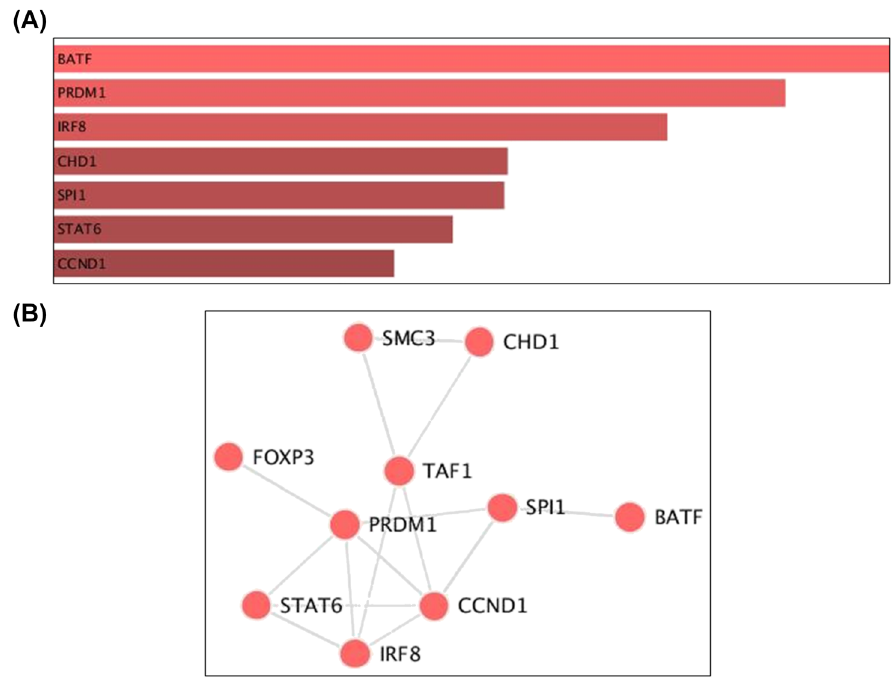
Figure 5: Identified significant TFs targeting DEGs and their interaction with other TFs/proteins.